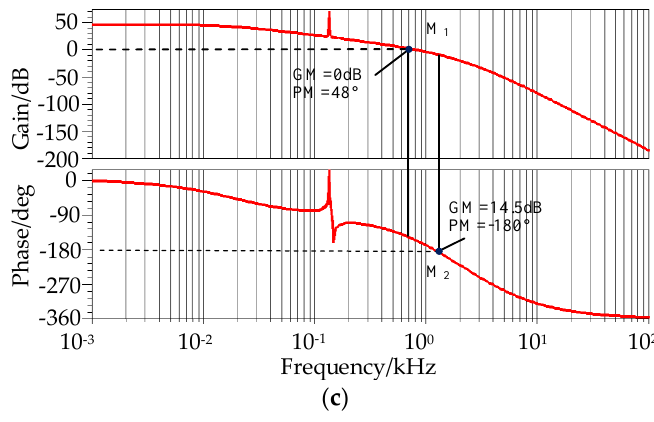
Figure 11. Frequency response. ( a ) Nyquist curves; ( b ) Enlarged drawing of the Nyquist curves; ( c ) Bode diagram.